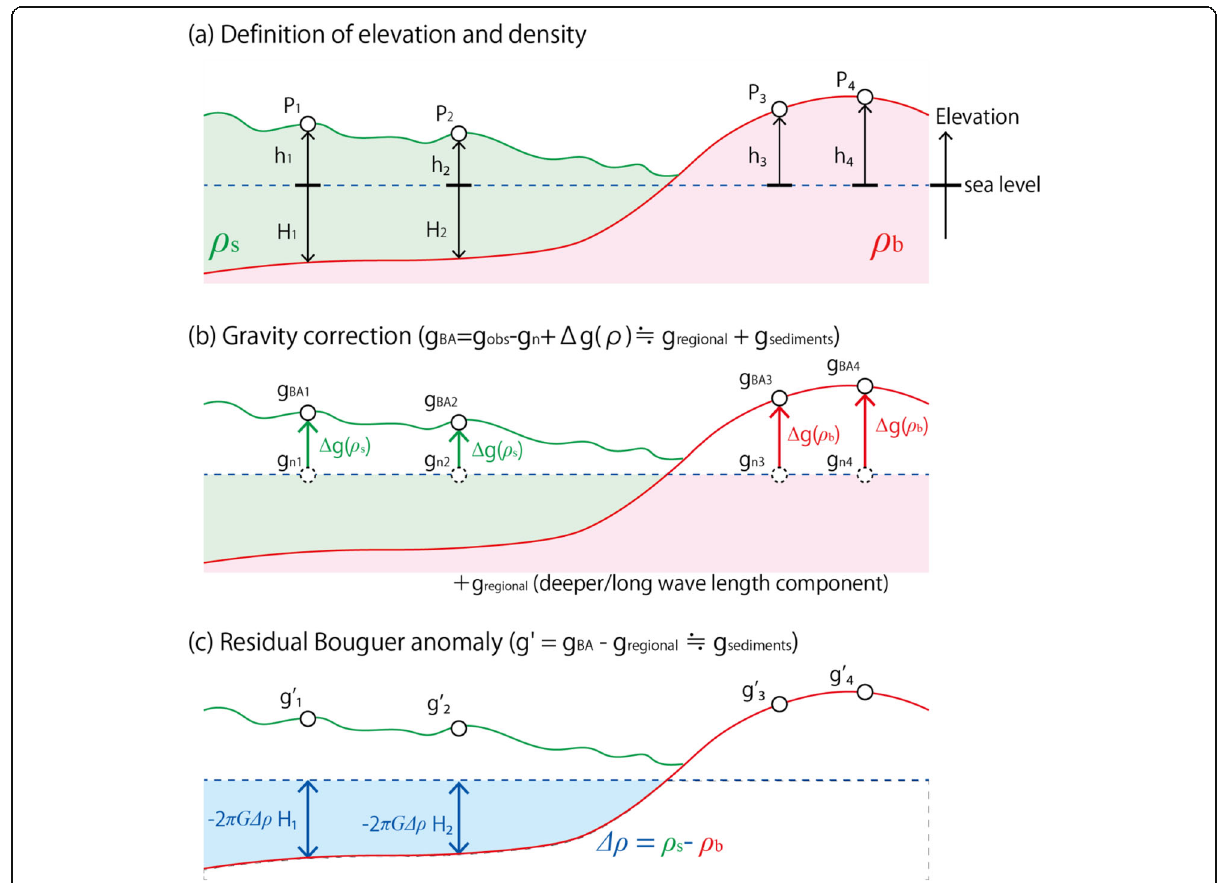
Fig. 4 Schematic diagrams showing the calculation of residual Bouguer anomalies at the boring sites and basement exposure points. a Definition of the elevation of points ( h ) and the density of the basement ( ρ b ) and one unit of sediments/sedimentary rocks ( ρ s ). The elevation of the buried basement surface is represented by H . b Gravitational corrections ( Δ g ) (Bouguer, free-air and terrain correction) are calculated using the density of the rock exposed at the observation points. g n is normal gravity in accordance with the Geodetic Reference System 1980 (GRS80). The corrected Bouguer anomaly ( g BA ) represents the Bouguer anomaly considered. c The residual Bouguer anomaly ( g ′ ) is obtained by removing the regional trend from the Bouguer anomaly ( g BA ). The residual Bouguer anomaly must consist of the gravity anomaly from the thickness of the sediments/ sedimentary rocks (i.e., the elevation of the basement